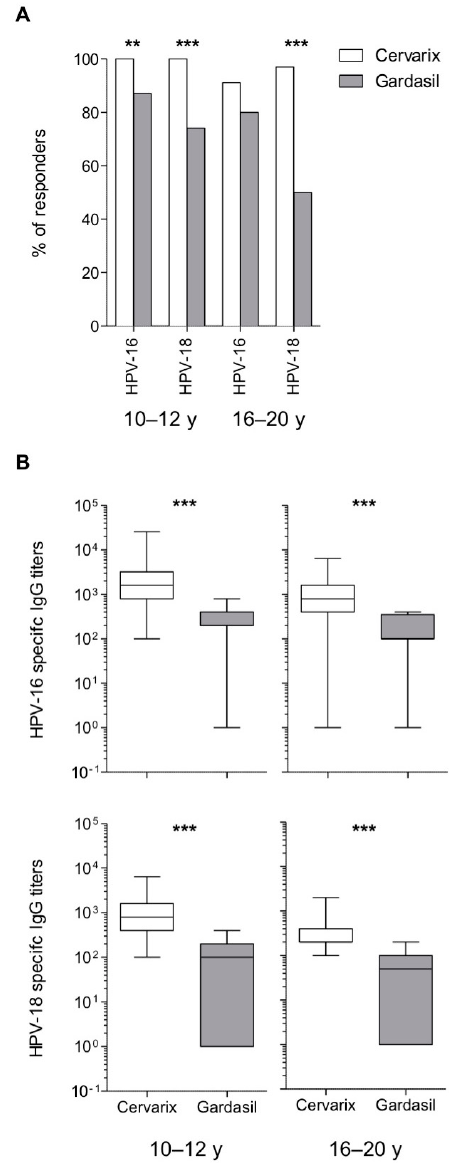
Figure 2. Maintenance of HPV-16 and HPV-18 specific IgG. ( A ) Frequency of study subjects with detectable binding HPV-16 and HPV-18 specific IgG. ( B ) HPV-16 and HPV-18 specific IgG titers measured by ELISA shown as box and whiskers plots. Statistical comparisons were made using Fisher’s exact probability test ( A ) and Mann-Whitney test ( B ), ** P < 0.01, *** P < 0.001; for HPV-16 10–12 y, n = 64 (Cervarix) and n = 31 (Gardasil); for HPV-16 16–20 y, n = 34 (Cervarix) and n = 20 (Gardasil); for HPV-18 10–12 y, n = 60 (Cervarix) and n = 31 (Gardasil); for HPV-18 16–20 y, n = 33 (Cervarix), and n = 20 (Gardasil).